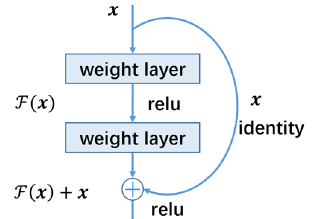
Figure 3. ResNet residual module